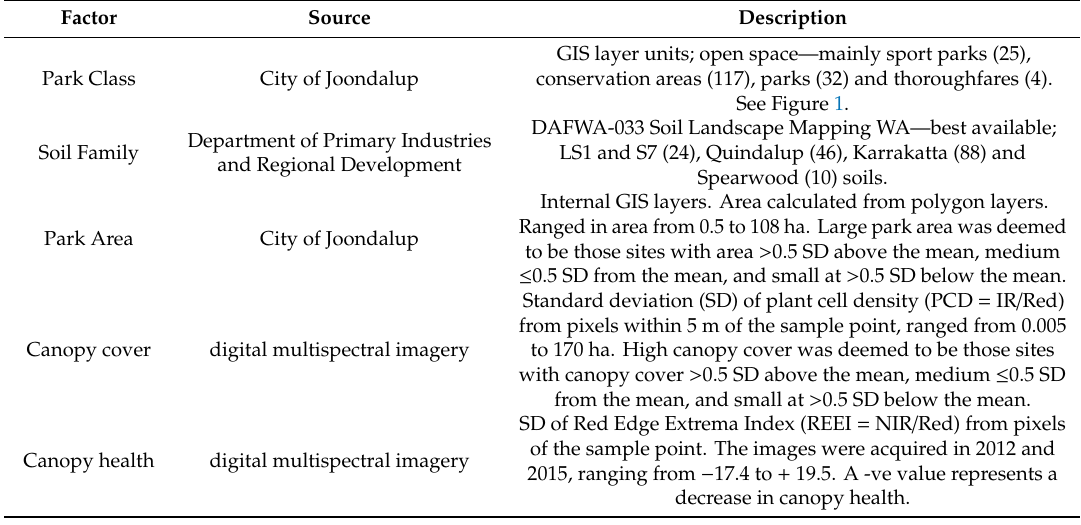
Table 1. Data sources and spatial scales for each of the variables examined for sampling sites from which Phytophthora was recovered ( n = 168). The number of sample sites in each category are in